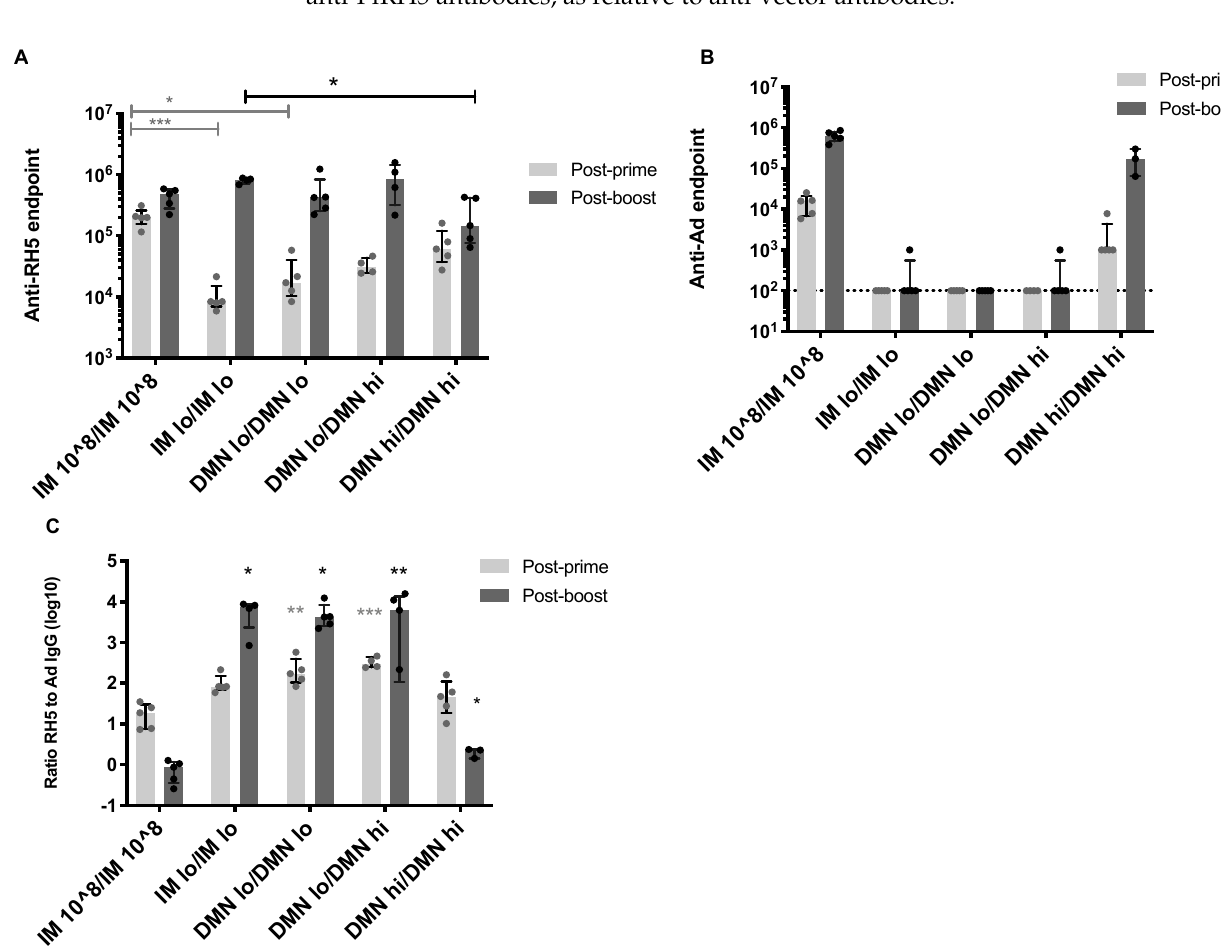
Figure 3. Antibody responses induced using a homologous dose and route in the prime and the boost. Female Balb/c mice ( n = 5 per group) were immunized on day 0 with AdHu5–PfRh5 by the IM route or using DMN patches. The conventional priming and boosting by the IM route, using 1 × 10 8 ifu acting as a control. Alternatively, mice were administered a low dose of 5 × 10 4 ifu by IM injection or DMN patch (“IM lo” or “DMN lo”) or a high dose of 5 × 10 7 ifu by DMN patch (“DMN hi”) . Serum IgG responses were assessed 8 weeks after the priming immunization. All mice were boosted on day 54 with a low or high dose of vaccine by the indicated route, and post-boost IgG responses were assessed 2 weeks after this boost. ( A ) IgG responses to the encoded antigen PfRH5. ( B ) IgG responses to the AdHu5 vector. ( C ) The ratio of the IgG titre to PfRH5 to the vector in each animal. * p < 0.05, ** p < 0.01, *** p < 0.001 by one-way ANOVA, Kruskal–Wallis test, with Dunn’s multiple comparison test compared to IM 10^8 in all graphs. Bars represent median, error bars represent interquartile range, circles represent individual samples.